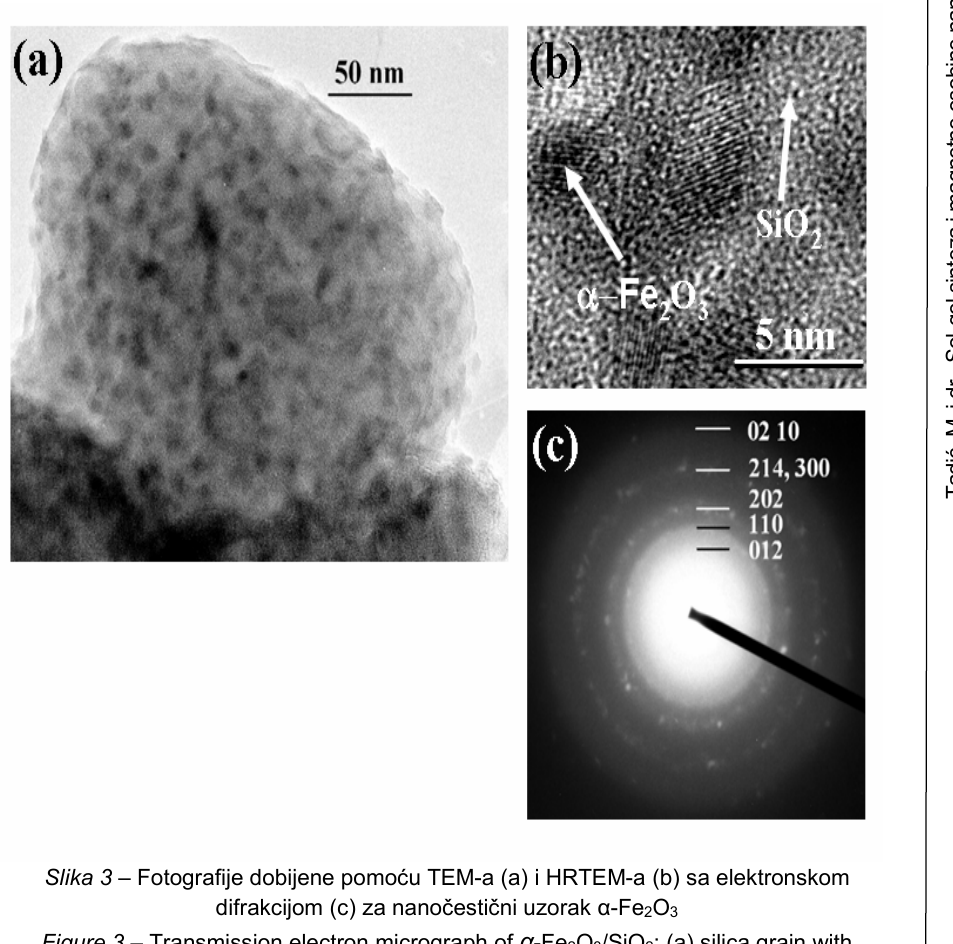
Figure 3 – Transmission electron micrograph of α -Fe 2 O 3 /SiO 2 : (a) silica grain with embedded α -Fe 2 O 3 nanoparticles; (b) high-resolution image of the selected grain region; (c) the SAED pattern of the same